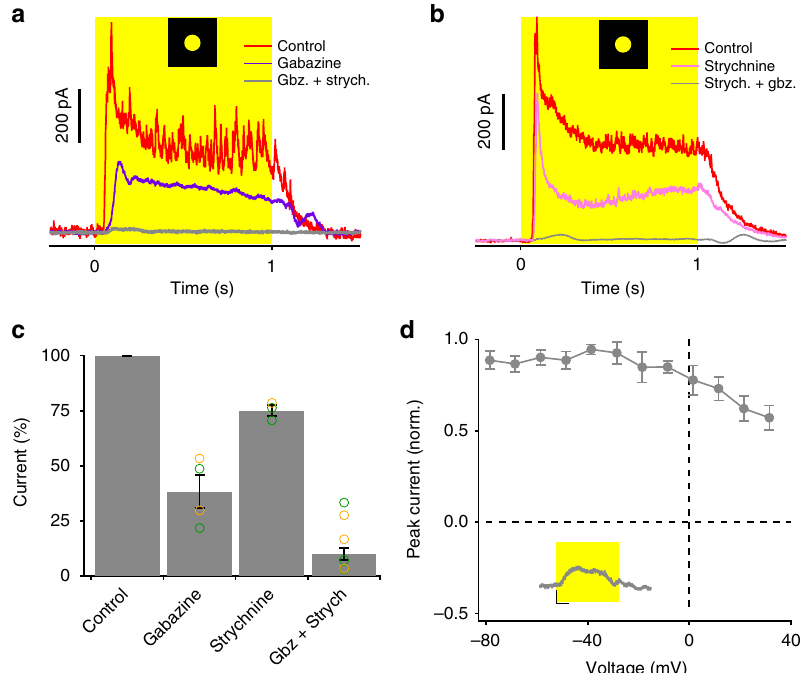
Fig. 5 Pharmacology of inhibitory conductances in OFF OS RGCs. a , b Effect of gabazine and strychnine on light step responses (200 μ m diameter) of example OFF OS RGCs from darkness. Gabazine and strychnine are bath applied fi rst in a , b , respectively. Cells are voltage clamped at E cat . c Percentage change in peak currents measured at E cat in inhibitory antagonists a , b . Error bars indicate SEM ( n = 4 for gabazine, n = 4 for strychnine and n = 8 for both drugs). d IV relationship for the residual current in both inhibitory antagonists. Inset shows light step response (200 μ m diameter) from darkness after application of both inhibitory blockers. Scale for inset: Y -axis = 100 pA, X-axis = 200 ms. Error bars indicate SEM across n = 8